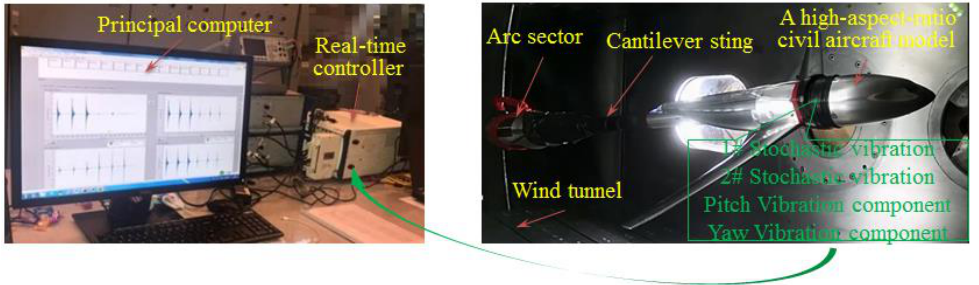
Figure 11. Real-time monitoring system in a continuous transonic wind tunnel.